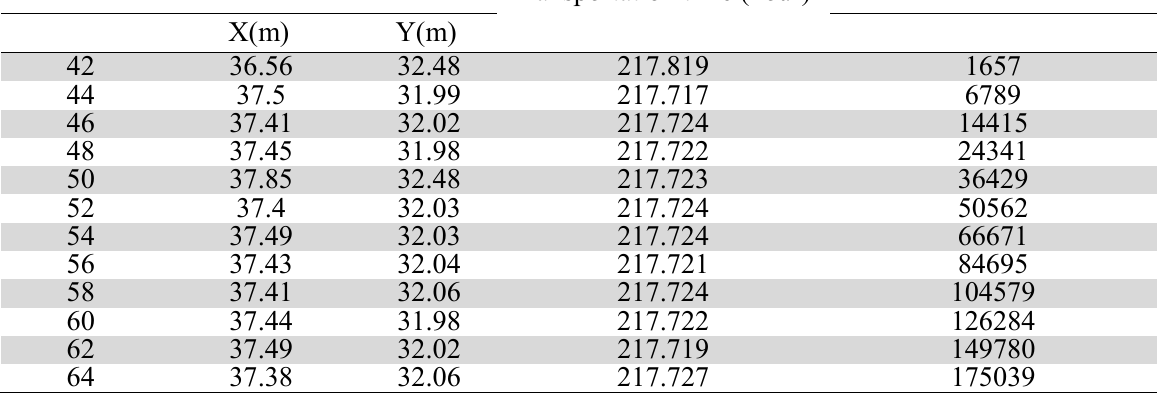
Output data of illustrative example Radius (m) Coordinates of tower